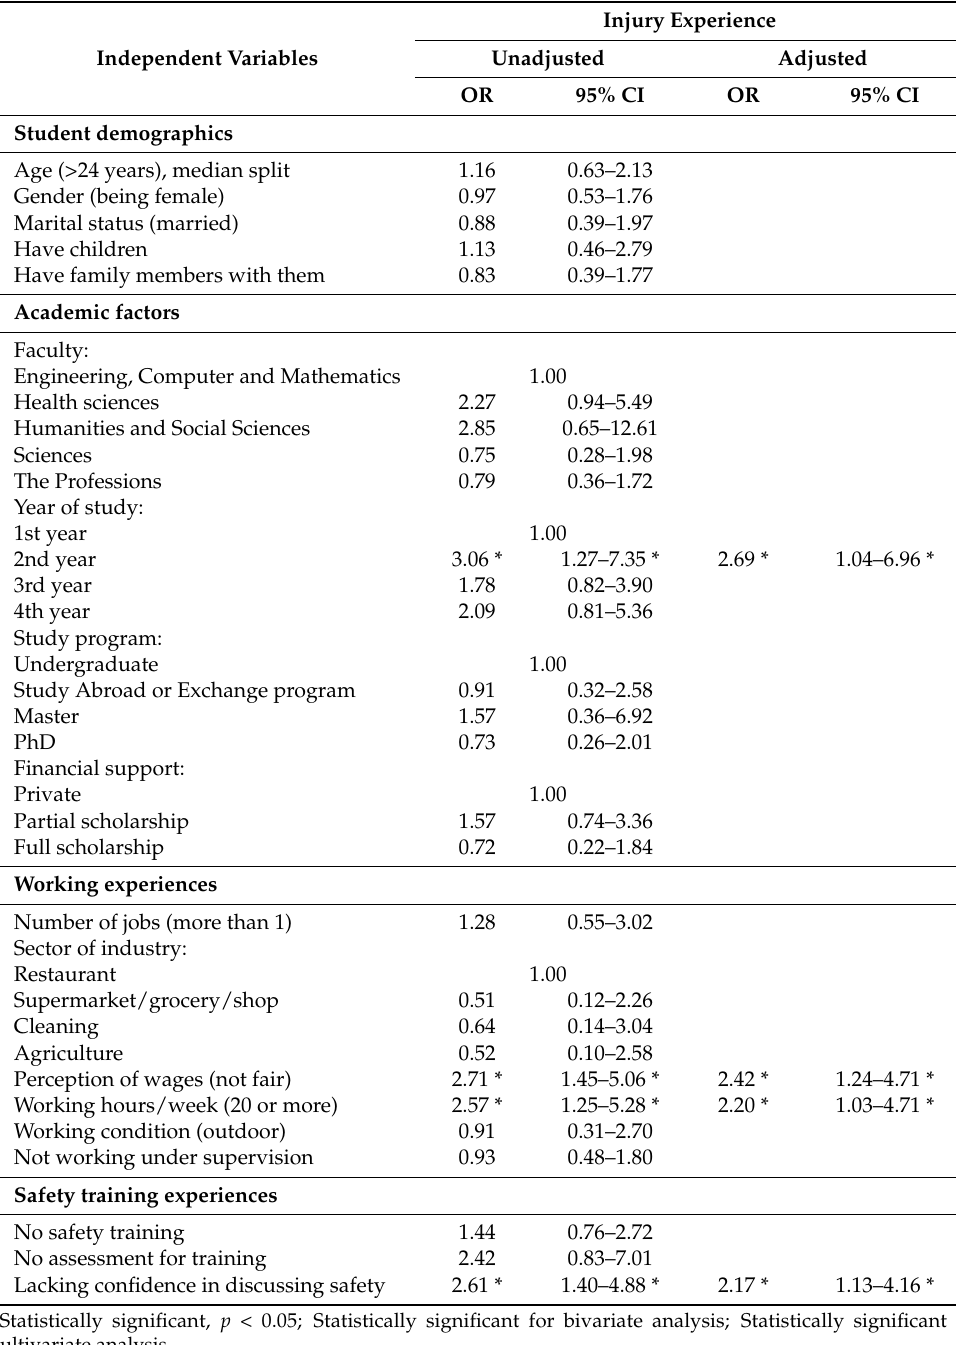
Table 2. Predictors of injury experience among international student